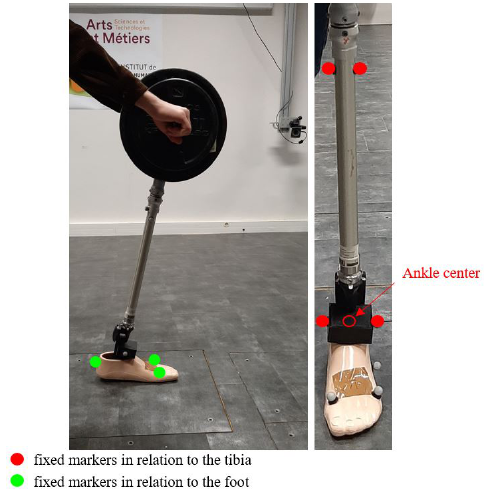
Figure 1. Stiffness test and marker set.